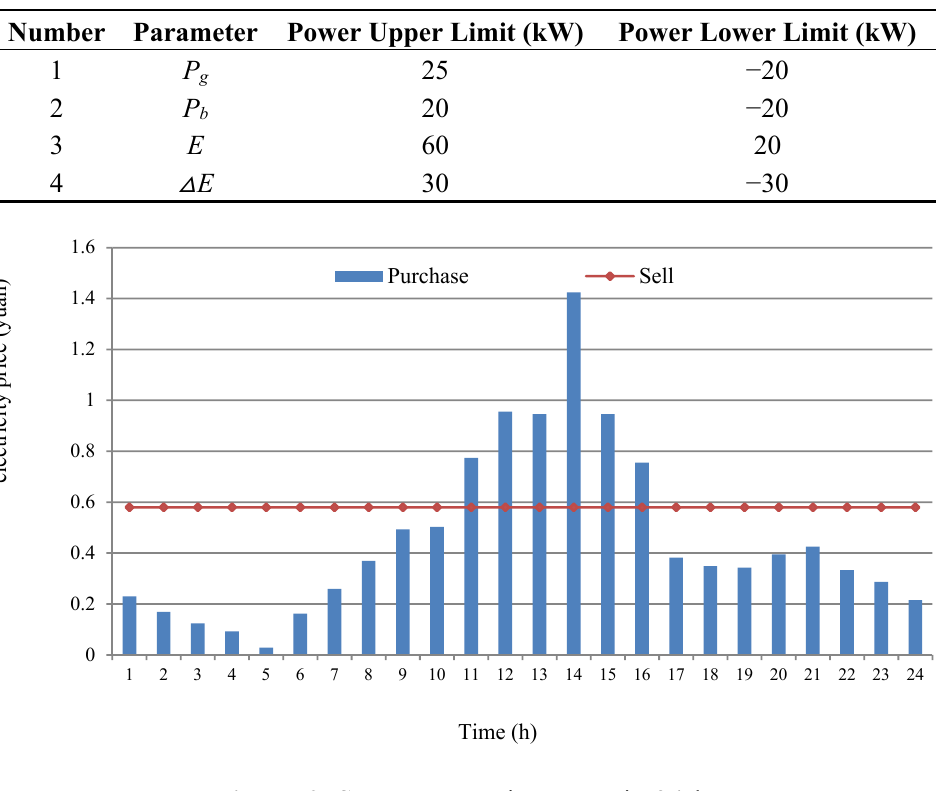
Figure 9. Spot power price curve in 24-h.